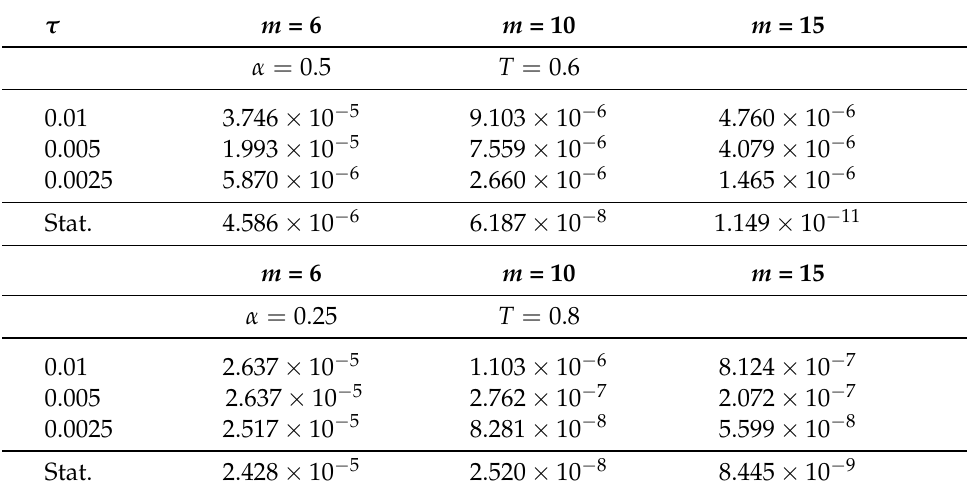
Table 3. The splitting method: errors e C ( N , J ) of the solution of the modified discrete scheme (23)–(24) for α = 0.5,0.25 and a sequence of parameters m